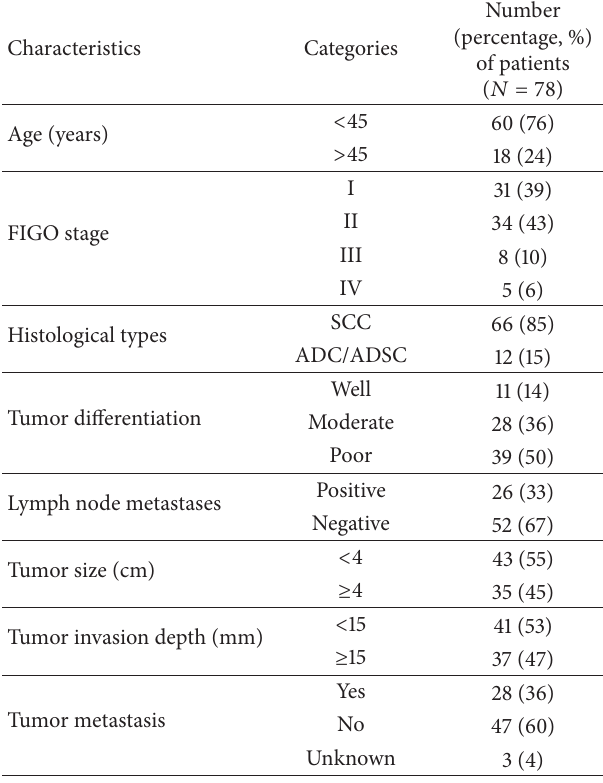
Table 1: Clinical characteristics of patients with cervical cancer.